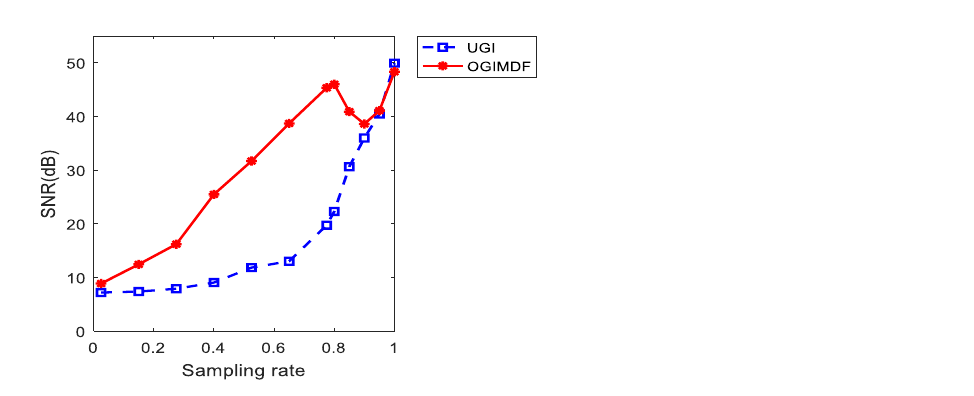
Figure 4. The SNR curves of reconstructed images with respect to SR for UGI and OGIMDF